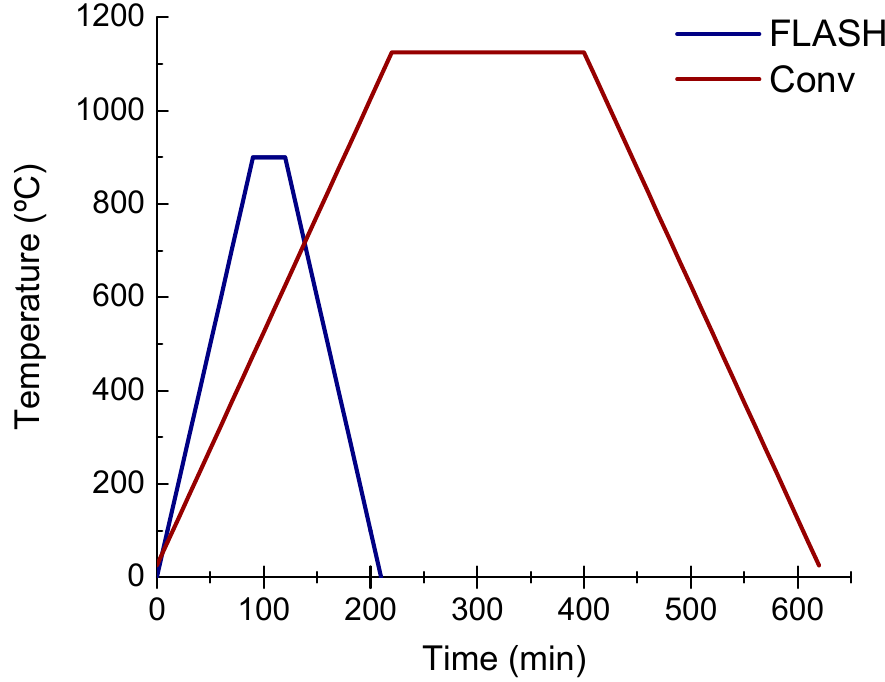
Figure 1. Thermal profiles used for sintering of KNN ceramics by conventional (Conv) (T max = 1125 ◦ C, time Total = 620 min) and Flash (T max = 900 ◦ C, time Total = 210 min) processes. A considerably lower thermal budget is involved for Flash when compared with conventional sintering.